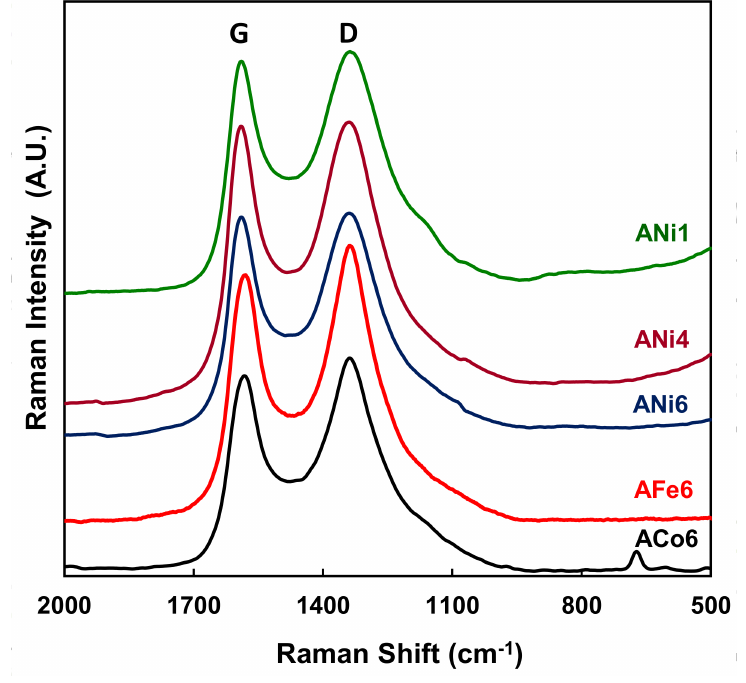
Figure 7. Raman spectra of the doped carbon aerogels. Table 2. Chemical characteristics of the carbon